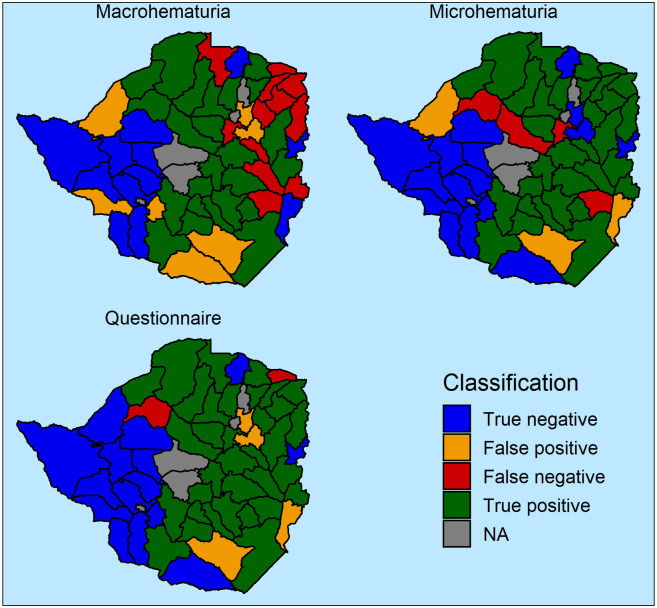
Classification of districts according to hematuria-based diagnostic methods.True negative indicates classification below threshold for both urine filtration and the given alternative; false positive indicates exceeding threshold in alternative but not in urine filtration; false negative indicates urine filtration above threshold but alternative below; and true positive indicates both urine filtration and alternative above threshold.